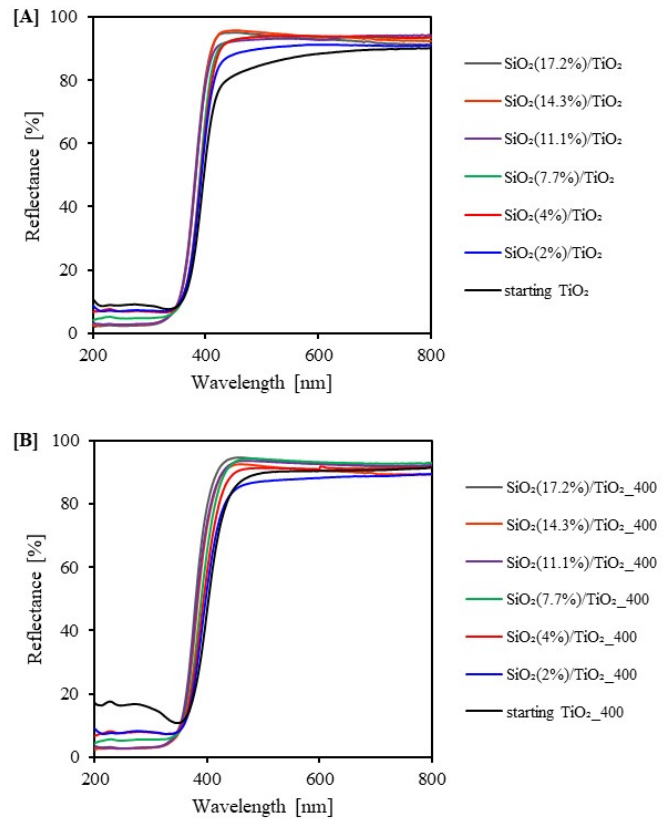
Figure 6. UV-Vis/DR spectra of starting TiO 2 and silica-modified TiO 2 prior ( A ) and after heat treatment ( B ).